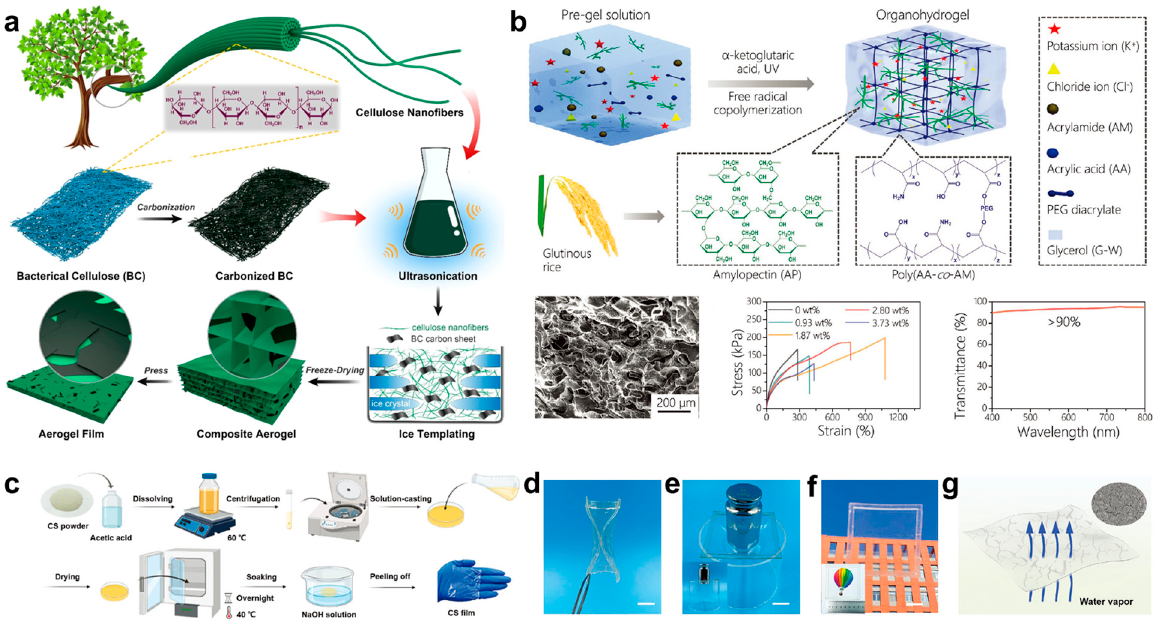
Figure 2. Fabrication processes and characterization of diverse polysaccharide-based epidermal electronics. ( a ) The preparation process of nanocellulose-based aerogel film [83]. ( b ) Schematic illustration showing the fabrication process and characteristics of amylopectin (AP) based hydrogel, including SEM image, strain-stress curves with different AP contents and transparency [93]. ( c ) Fabrication process of chitosan (CS) membrane. ( d ) Photograph showing flexibility of CS membrane. ( e ) Photograph of CS membrane pressed by a 500 g weight. ( f ) Outdoor and indoor (inset) images illustrating the transparency of CS membrane. ( g ) Image showing the breathability of CS membrane and SEM image (inset) of CS surface [98].